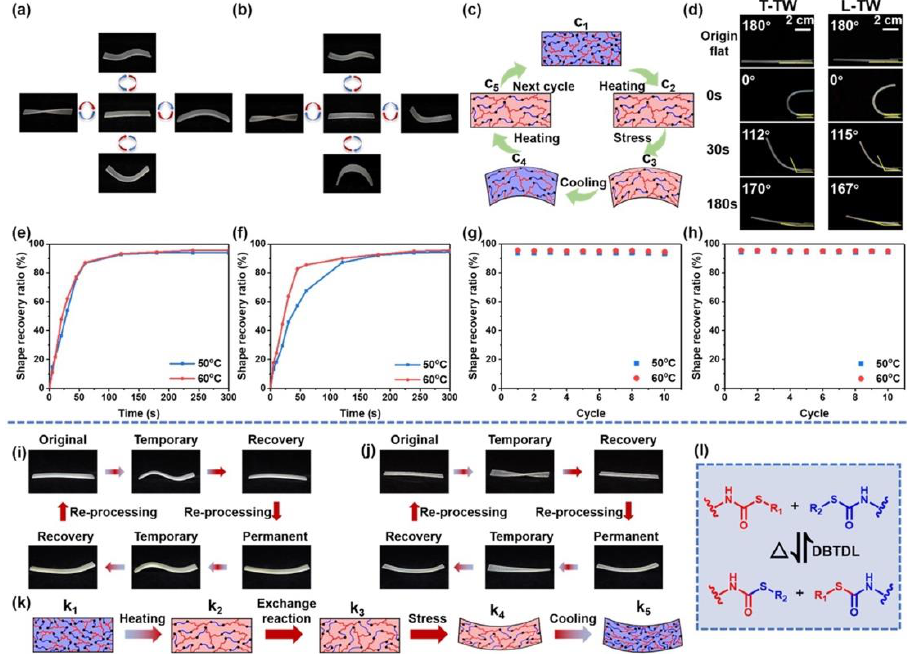
Figure 33. Shape deformation properties of transverse (T-TW, ( a )) and longitudinal (L-TW, ( b )) transparent wood. ( c ) Shape memory mechanism of transparent wood. ( d ) Shape restorability of T-TW and L-TW at 50 °C. ( e , f ) Shape recovery curves of transverse (T-TW) and longitudinal (L-TW) transparent wood at 50 °C and 60 °C. ( g , h ) Shape recovery ratio of T-TW and L-TW within 10 cycles at 50 °C and 60 °C. ( i , j ) Shape reprocessing performance of T-TW and L-TW. ( k ) Shape reprocessing mechanism of TW. ( l ) Exchange reaction mechanism of vitrimers above topology freezing transition temperature (Tv). DBTDL = Dibutyltin dilaurate. Reprinted with permission from [47], copyright 2022, Elsevier.